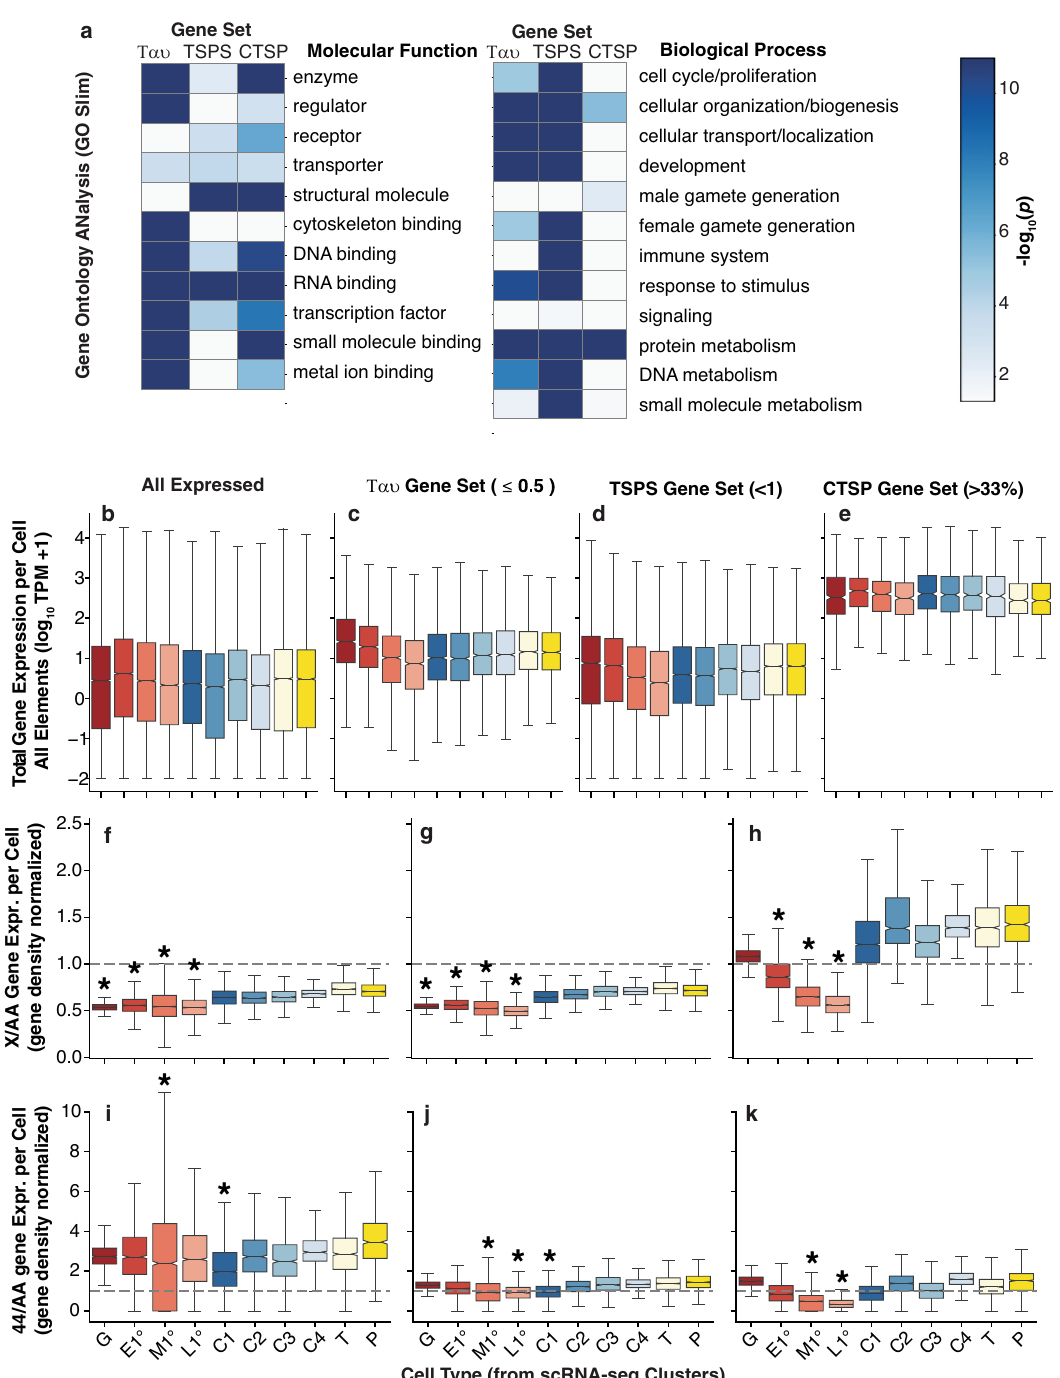
Fig. 4 Gene expression patterns across cell types and chromosome elements for different gene subsets. a Ribbons showing p-values for Gene Ontology enrichments (blue scale) in three gene sets representing widely expressed genes. b – e Total gene expression (y-axis) by cell-type ( x -axis) in L3 testis scRNA-seq for different gene subsets. f – h X chromosome, and i – k 4th chromosome expression relative to major autosomes by cell type as in Fig. 3a, b. c , f , i Tau: genes not tissue-speci fi cally expressed ( τ ≤ 0.5 from adult tissues Fig. 1). d , g , j TSPS: genes not tissue-speci fi cally expressed (TSPS ≤ 1 from adult tissues Fig. 1). e , h , k CTSP: genes not cell type-specially expressed ( ≥ 33% of cells). The number of cells scored are: G = 1065, E1 = 1267, M1 = 4570, L1 = 2667, C1 = 4064, C2 = 1230, C3 = 910, C4 = 945, T = 1379, P = 868. Boxplots (box = interquartile range (IQR), notch = 95% con fi dence interval of median, whiskers = ±1.5xIQR). Signi fi cance at p ≤ 0.01 determined by permutation testing